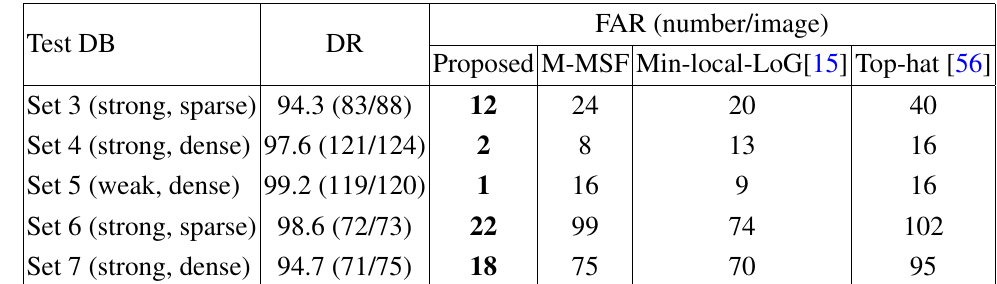
Table 5. Statistical performance comparisons of the proposed method and baseline method. DR denotes the detection rate, and FAR denotes the number of false alarms per image. DB,